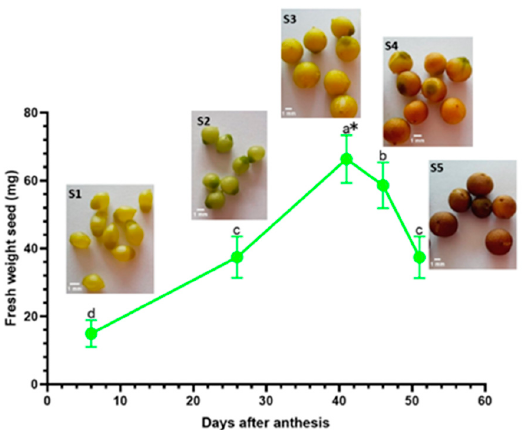
Figure 4. Evaluation of fresh weight of A. pelegrina seeds at different maturity stages. S1: Seed stage